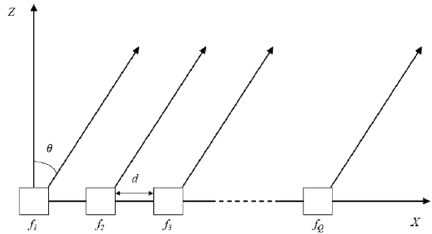
Fig.1 Q-element linear